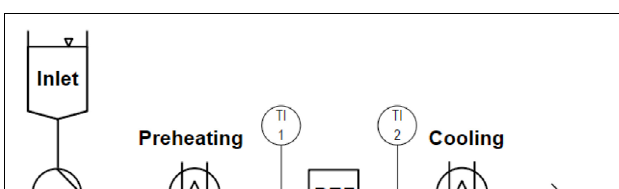
Further given are the conversion factors (c chamber ) for the determination of average electric field strength from the applied voltage, depending on the individual treatment chamber design. Value for the co-linear chamber was determined by Jaeger et al. (2009).